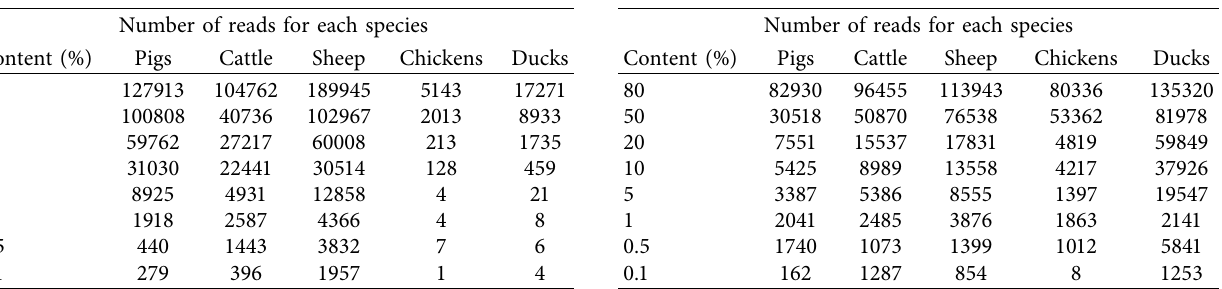
Figure 1: NGS sequencing results of mixed samples with an equal mass ratio. Table 2: NGS sequencing results by 16S_Ki primer. Table 3: NGS sequencing results by GHR_1